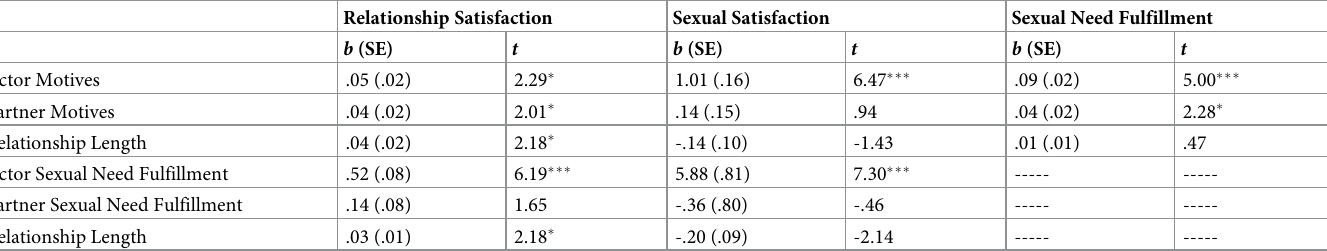
Table 3. Associations between actor and partner sexual motives and relationship satisfaction, sexual satisfaction, and sexual need fulfillment with the first